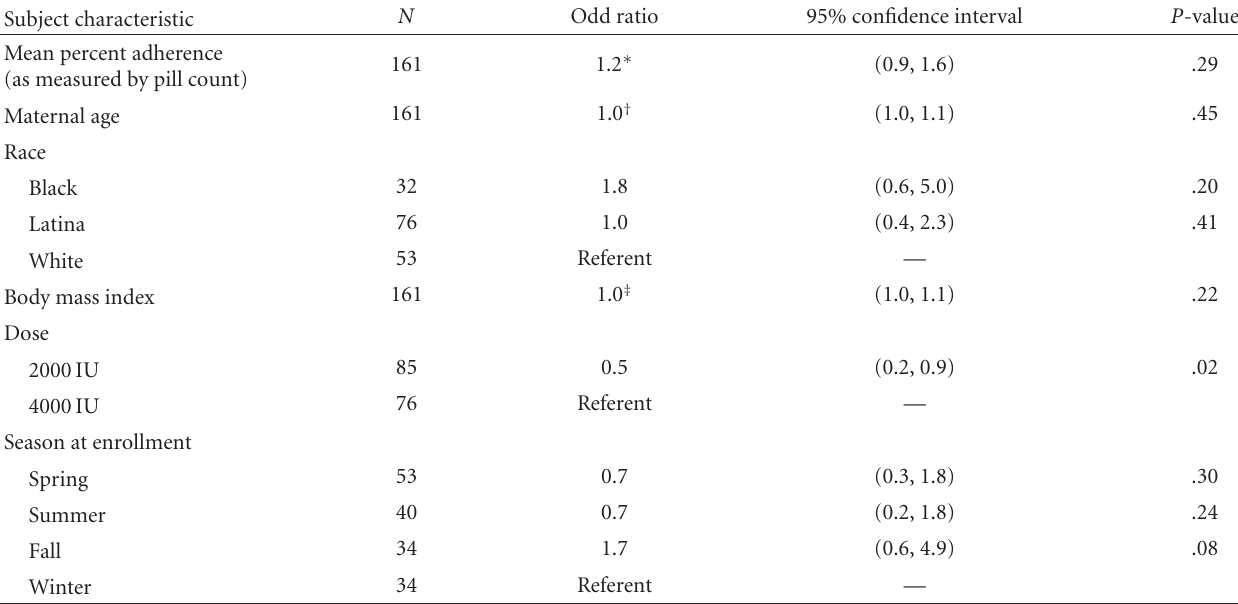
Table 2: Results of the primary logistic regression model predicting adherence as determined by the novel serum 25(OH)D definition. Subject